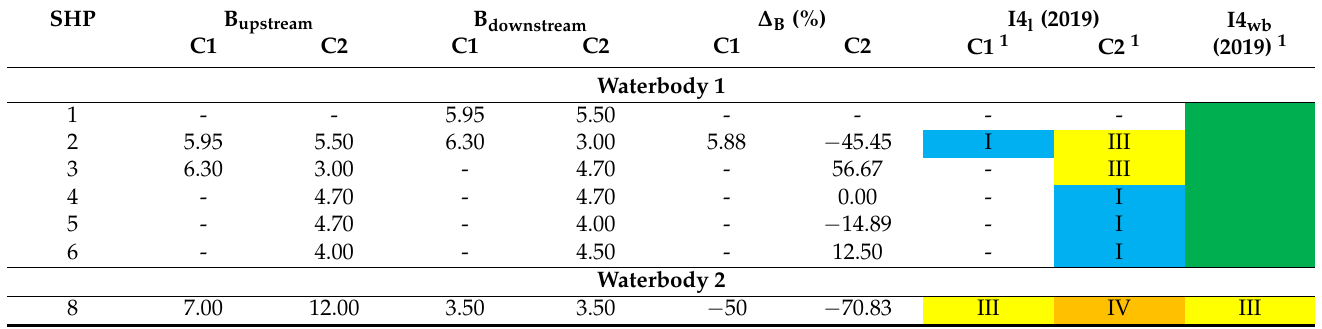
Table 8. The results of the indicator width variation (local and waterbody